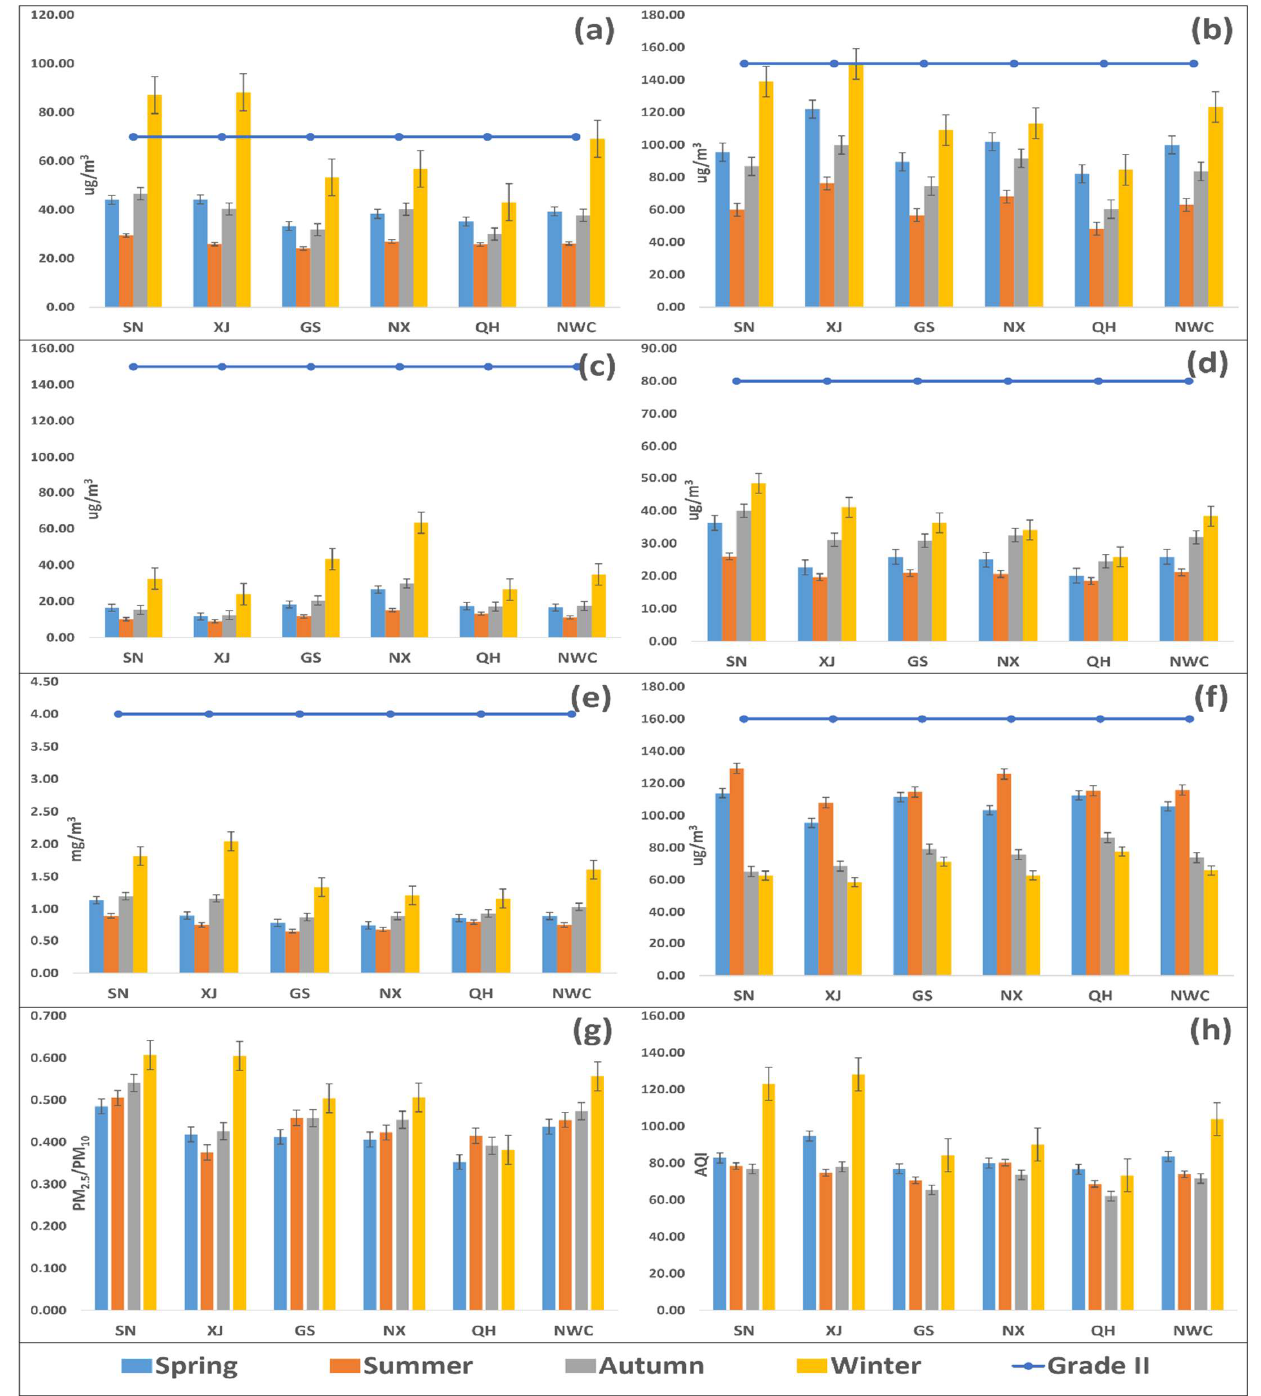
Figure 3. Seasonal variation of PM 2.5 ( a ), PM 10 ( b ), SO 2 ( c ), NO 2 ( d ), CO ( e ), O 3 ( f ), PM 2.5 /PM 10 ratio ( g ), and AQI ( h ) in five provinces (Shaanxi (SN), Xinjiang (XJ), Gansu (GS), Ningxia (NX), and Qinghai (QH)) of northwest China (NWC) and NWC as a whole between 2015 and 2018. Descriptions are as follows: light blue bar (spring), orange bar (summer), grey bar (autumn), yellow bar (winter), and blue line with dots (CAAQS Grade II standards, daily mean). The abbreviations are as follows: PM 2.5 (fine particulate matter), PM 10 (coarse particulate matter), SO 2 (sulfur dioxide), NO 2 (nitrogen dioxide), CO (carbon monoxide), O 3 (ozone), PM 2.5 /PM 10 (ratio of PM 2.5 with PM 10 ), and AQI (air quality index).